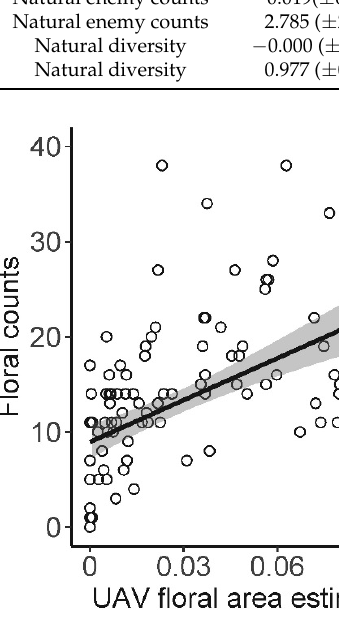
Figure 2. Correlation between floral area extracted from UAV images and visual counts of flowers within a 0.25 m 2 quadrat. For ease of interpretation, the line represents the linear relationship between untransformed floral counts with the shaded area indicating 95% confidence intervals (see Table 2).